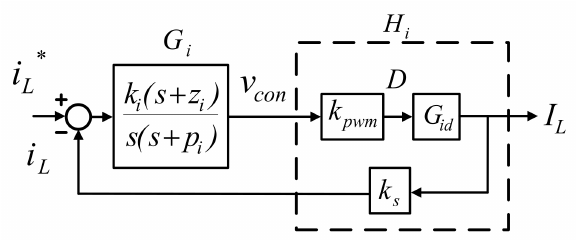
Figure 9. Block diagram of inductor current control